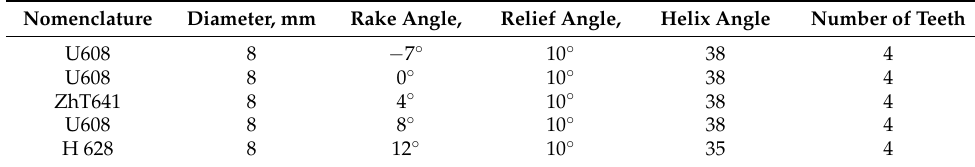
Table 4. The main geometric parameters of the cutters.